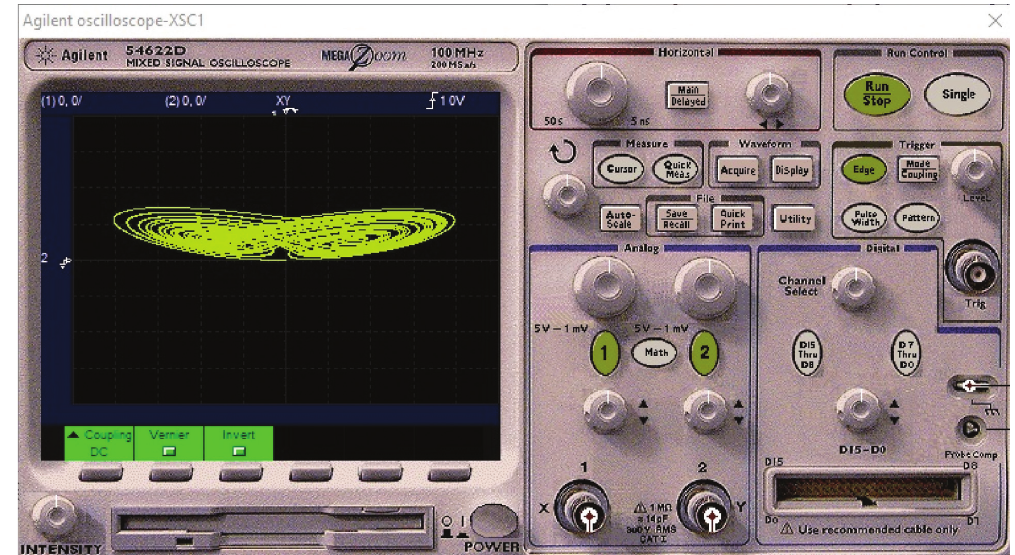
versus the state variable x 2